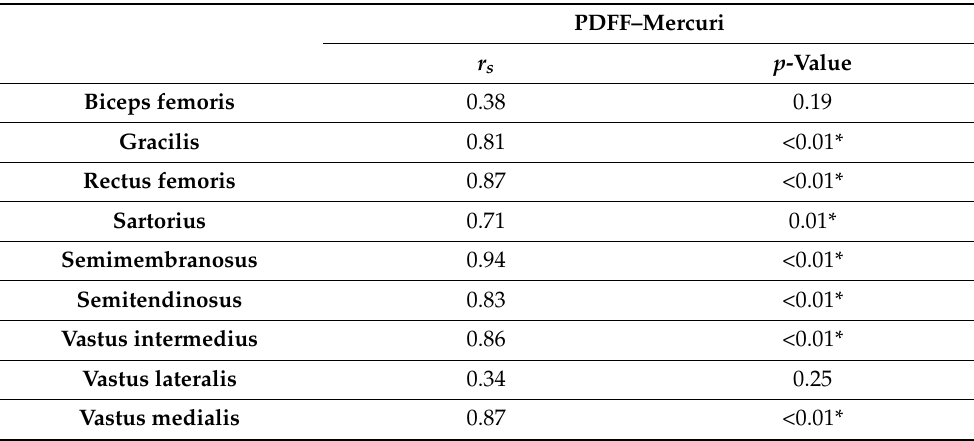
Table 6. Correlation of the proton density fat fraction (PDFF) with semi-quantitative grading accord- ing to the Mercuri scale. Table showing the results of correlation analyses between PDFF values and Mercuri grading. Spearman correlation coefficients ( r s ) and corresponding p -values are shown sepa- rately for the biceps femoris, gracilis, rectus femoris, sartorius, semimembranosus, semitendinosus, vastus intermedius, vastus lateralis, and vastus medialis muscles. *: statistically significant after Bonferroni correction for multiple comparisons ( n = 9).